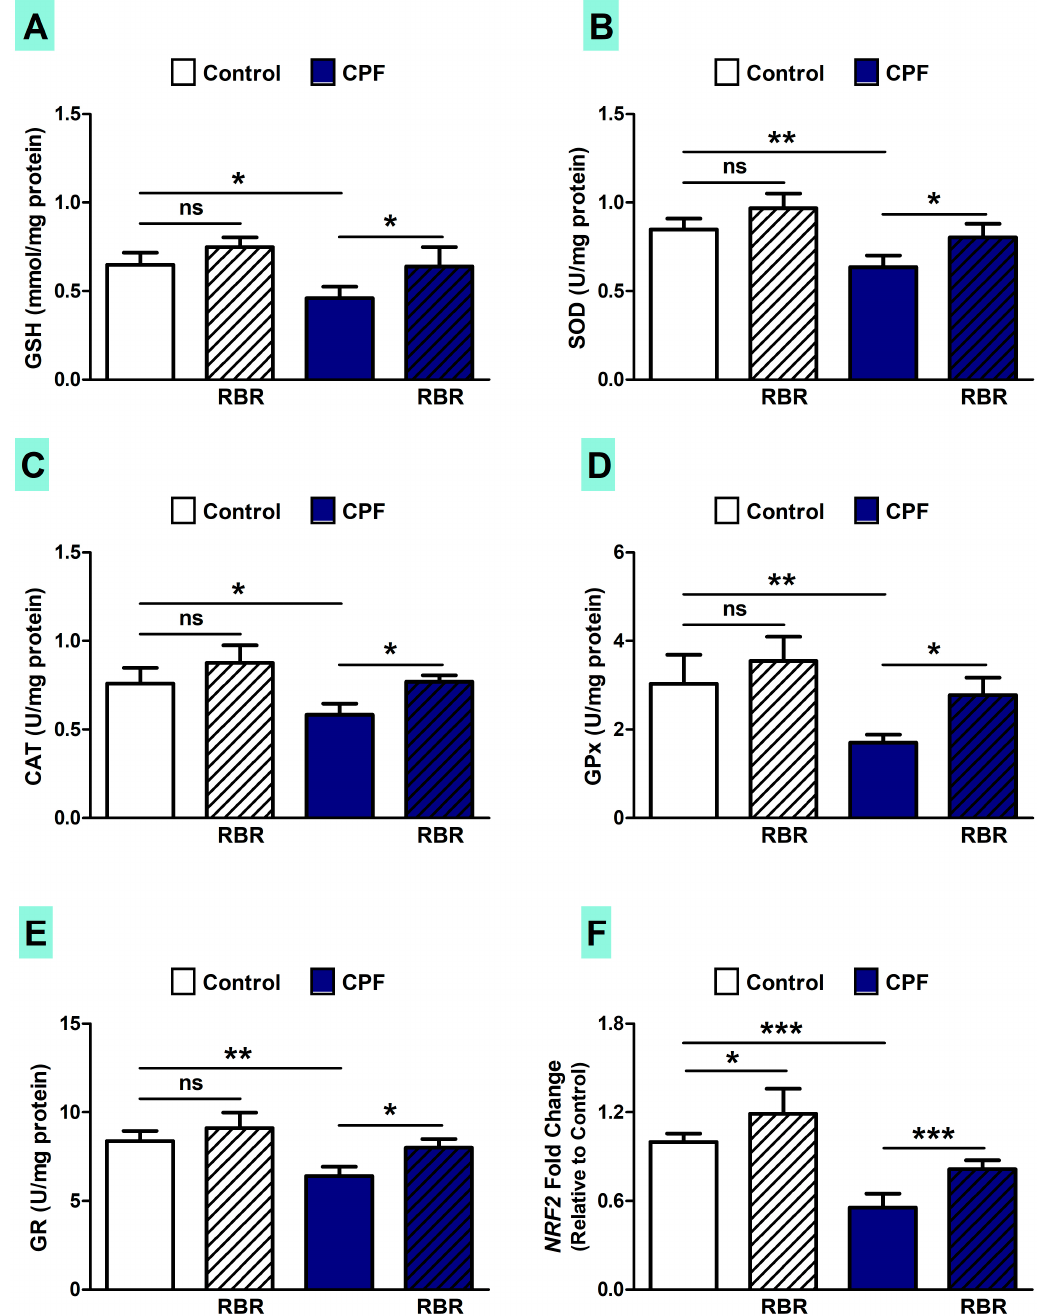
Figure 6. RBR enhances cellular antioxidants and up-regulates Nrf2 in control and CPF-induced rats. RBR increases ( A ) GSH content, and activity of ( B ) SOD, ( C ) CAT, ( D ) GPx and ( E ) GR in the liver of CPF-intoxicated rats. ( F ) RBR increased hepatic Nrf2 expression. Data are mean ± SD, (N = 7). * p < 0.05, ** p < 0.01 and *** p < 0.001. ns = non-significant.